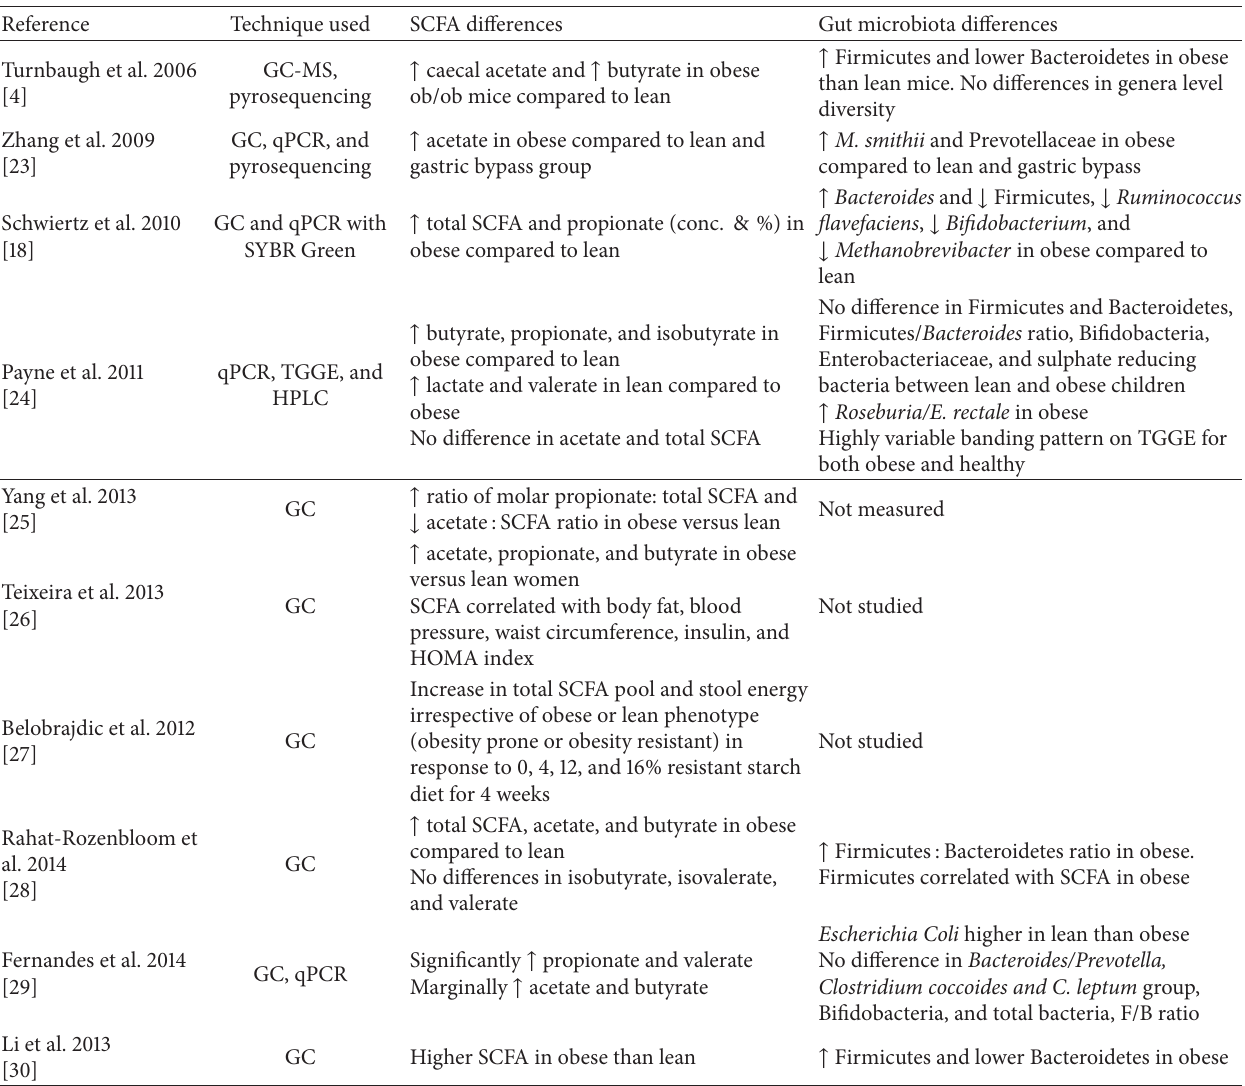
Table 2: Studies looking at differences in SCFA in faecal or caecal samples in obese versus lean phenotypes in animal and human